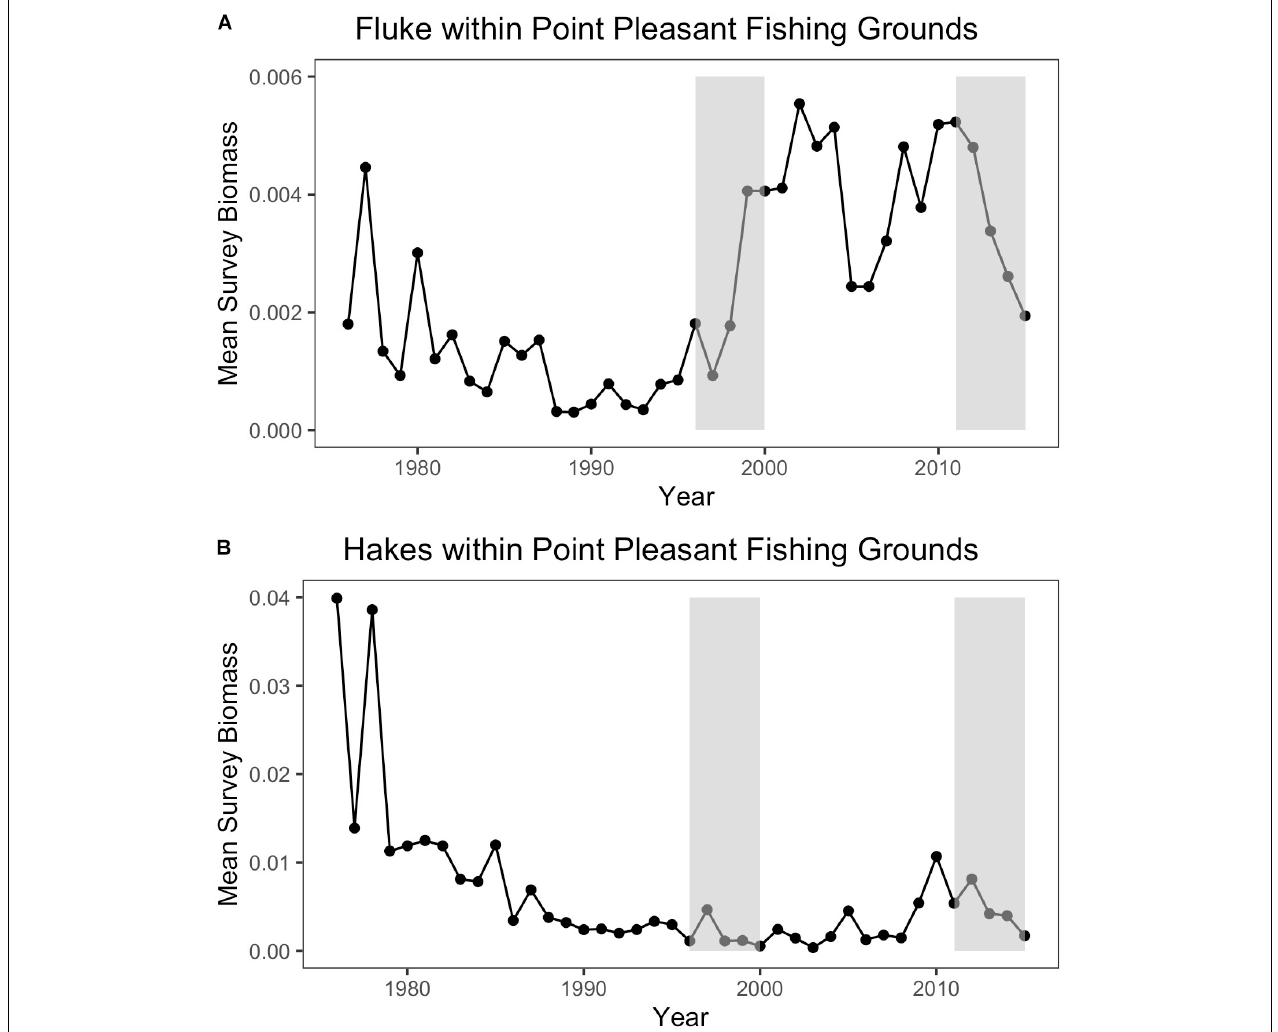
FIGURE 10 | (A) Annual mean species biomass for fluke (top) and (B) hakes (bottom) within Point Pleasant’s recent fishing grounds. The baseline (1996–2000) and the recent (2011–2015) periods are represented by the shaded